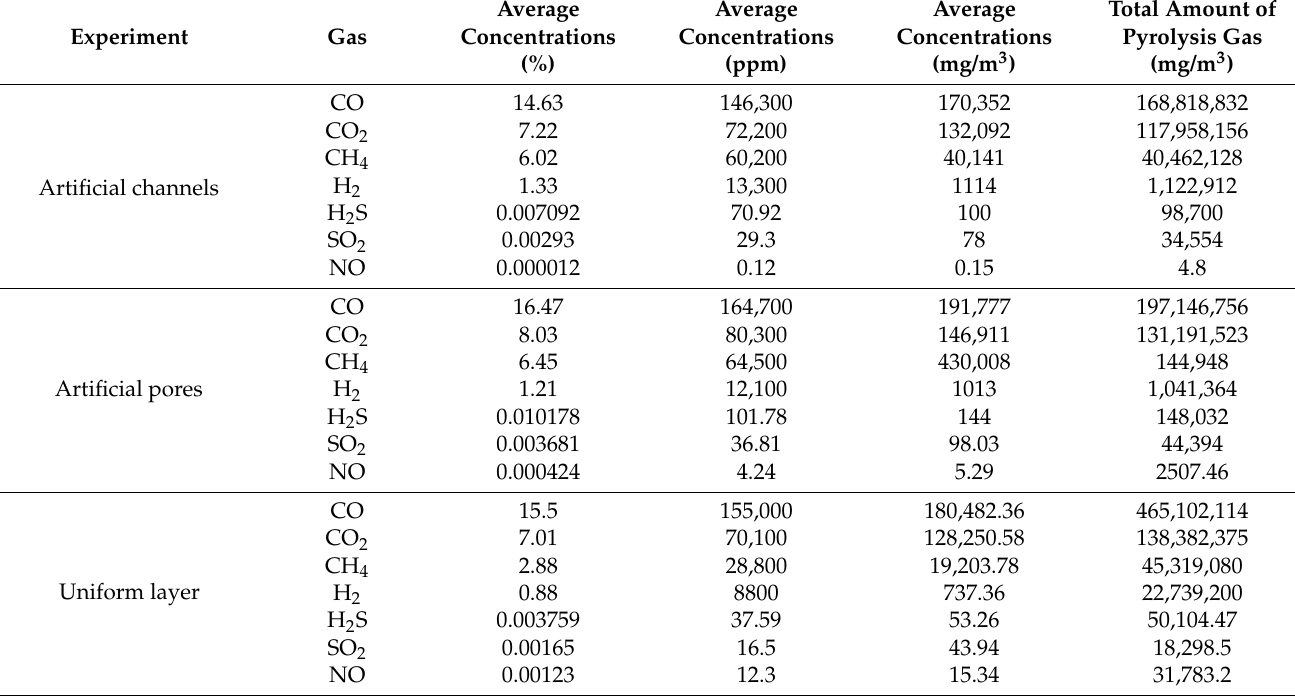
Table 6. The yield of the main